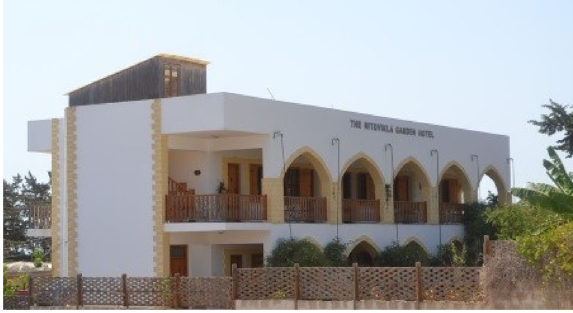
Fig. 16 Nitovikla Garden Hotel. An example of reinforced concrete construction — Kumyal ı k.